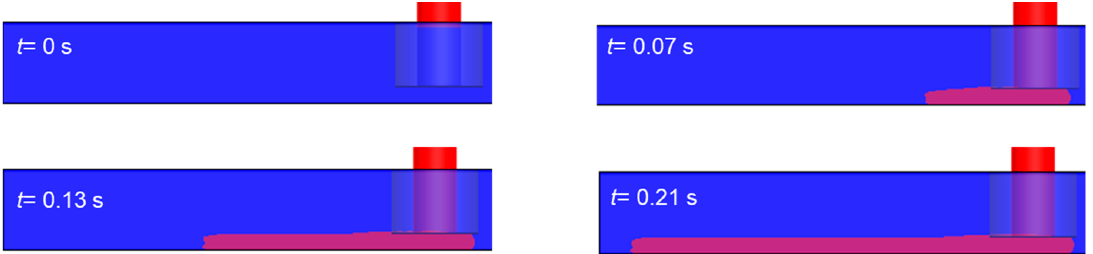
Figure 4. Time evolution of the PLA melt extrusion process: The melt flow is visualized by showing α ≥ 0.5 as red color. The surrounding atmosphere (0 ≤ α < 0.5) is represented as blue.